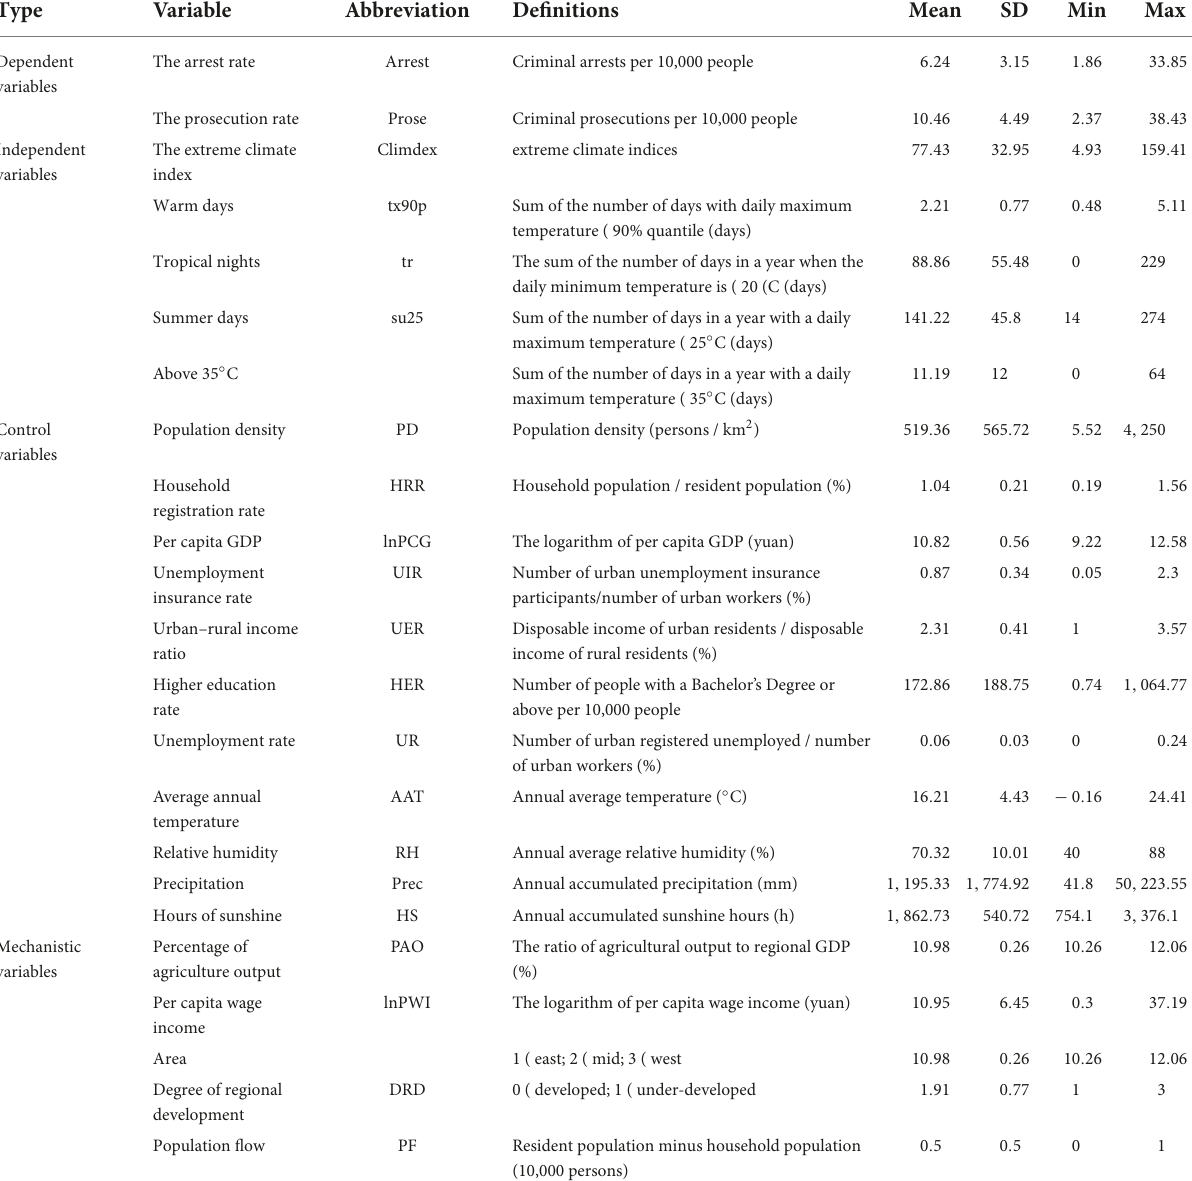
TABLE 1 Descriptive statistics of all